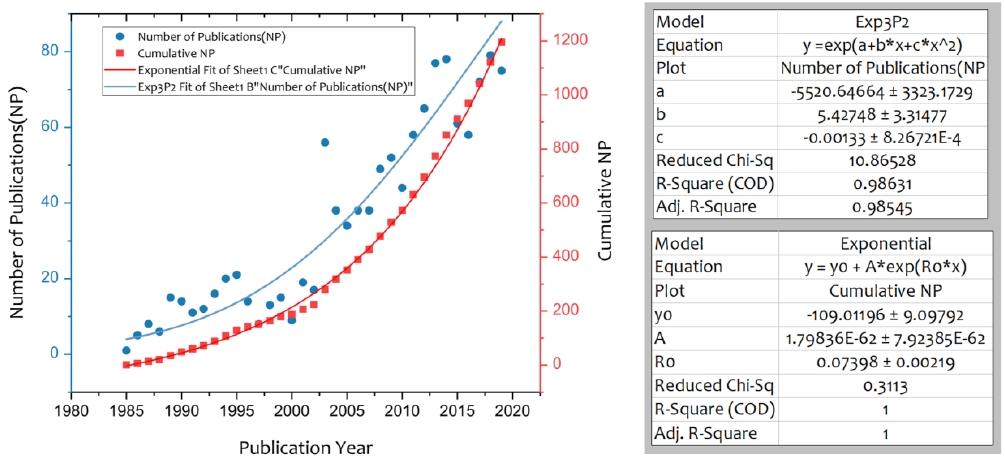
Figure 1. Yearly outputs of risk communication research.